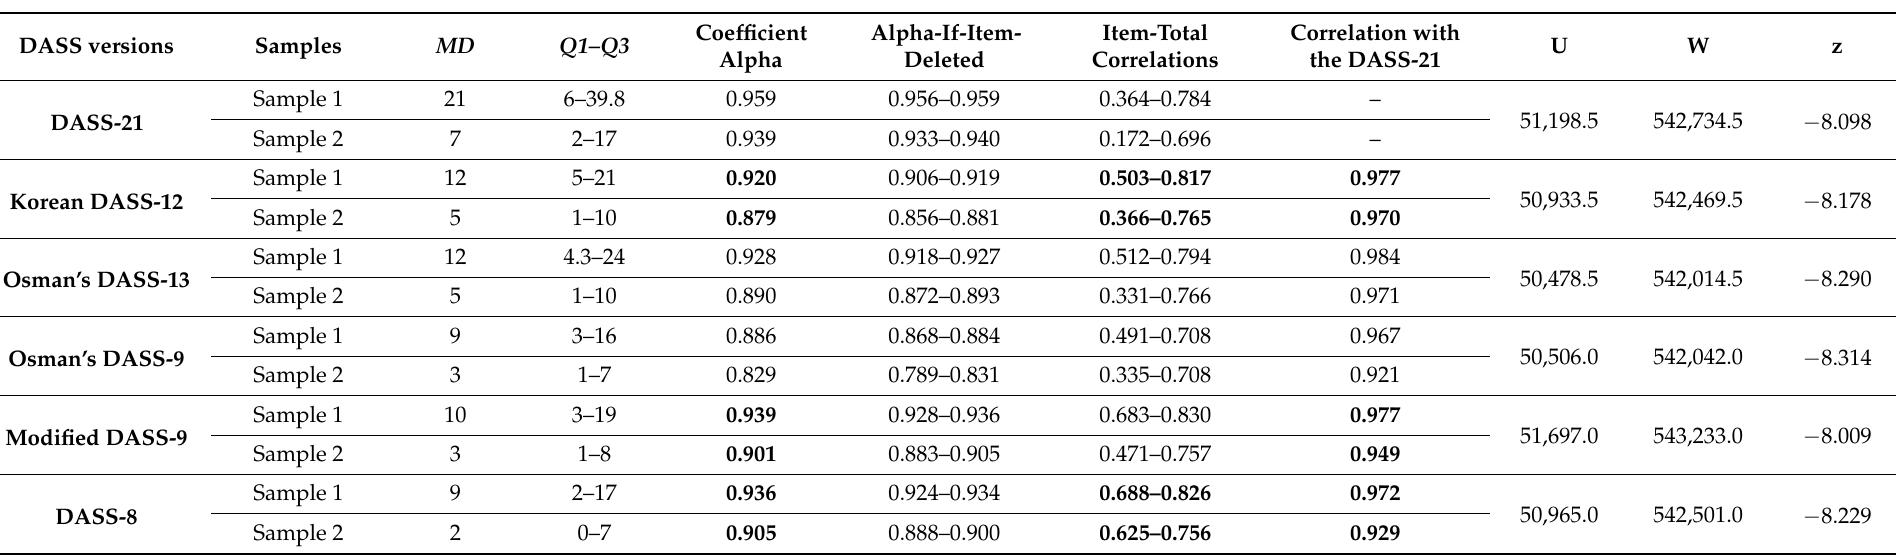
Table 4. Descriptive statistics, internal consistency, predictive validity, and discriminant validity of the Depression Anxiety Stress Scale 21 and its shortened